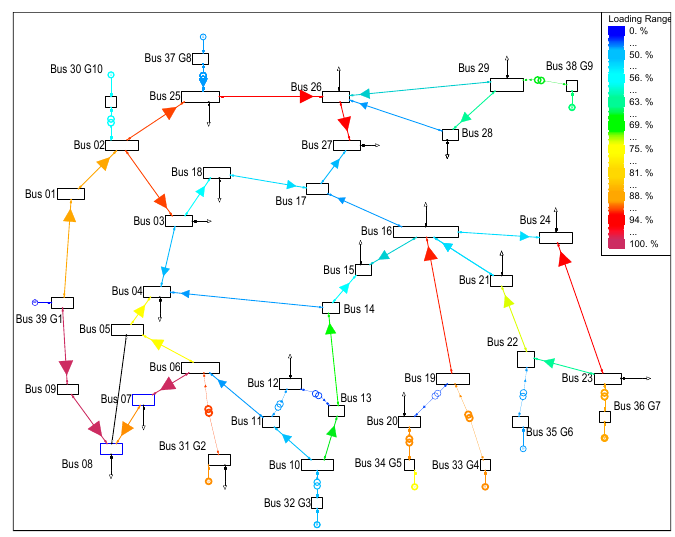
Figure 7. Simulation of maximum loadability of elements when considering N − 1contingencies after the outage of line 05-08.